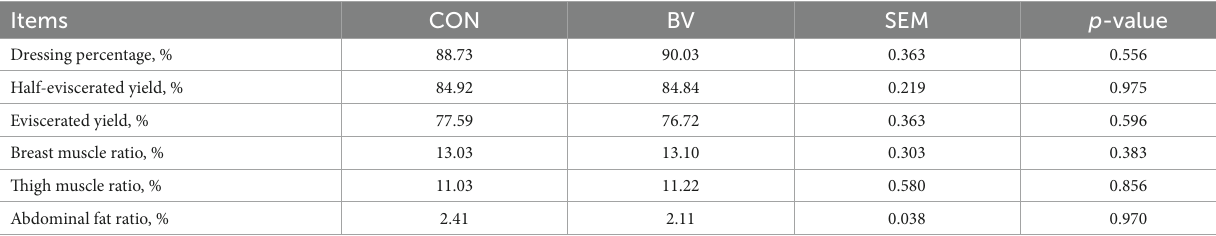
TABLE 1 Effect of Bacillus velezensis LB-Y-1 on slaughter performance of broilers at day 42 ( n =